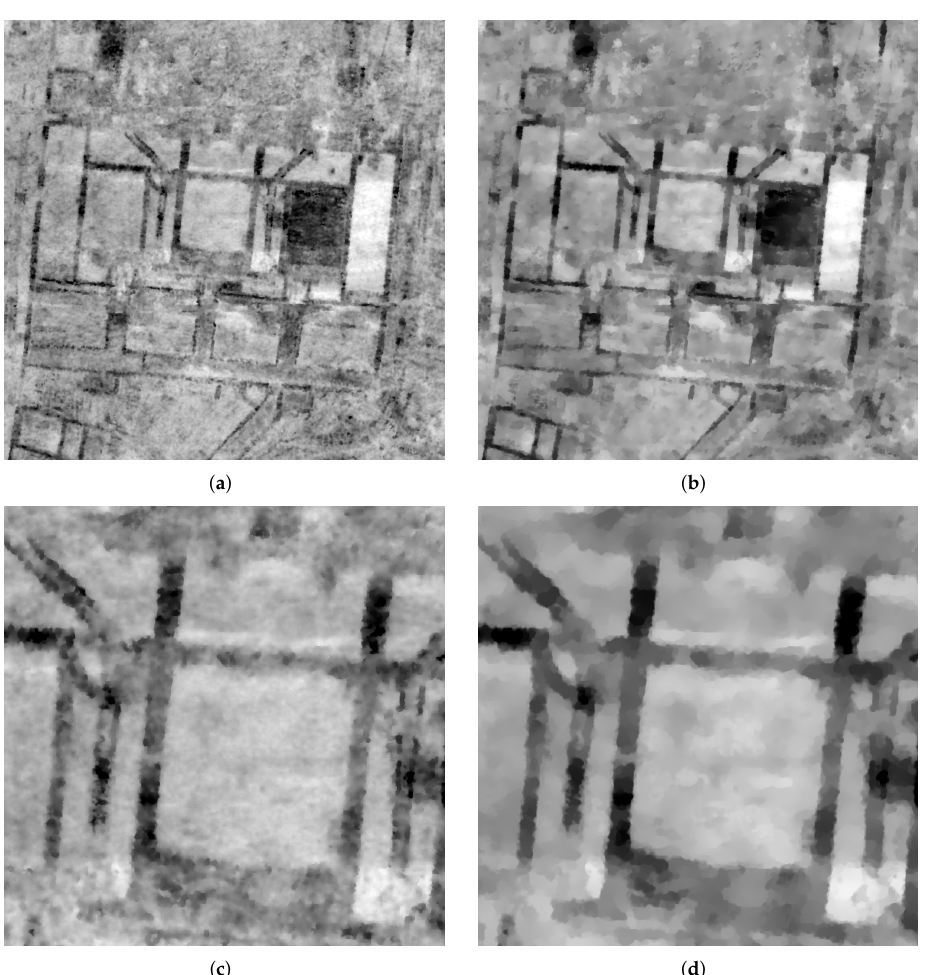
Figure 7. GPR data denoise using the TV-L1 filter: Dataset values converge to the representative values of their respective regions depending on the choice of parameter λ . High values preserve smaller details such as the side walls of the Roman sewerage ducts on both sides of the forum of Carnuntum. Large features, such as walls, are still noisy and the filtered image more similar to the original image in Figure 4 ( a , c ). A lower λ yields images with largely homogeneous wall. Still, their contours remain well defined and sharp. Small details such as the cavity of the sewer begin to blur or disappear ( b , d